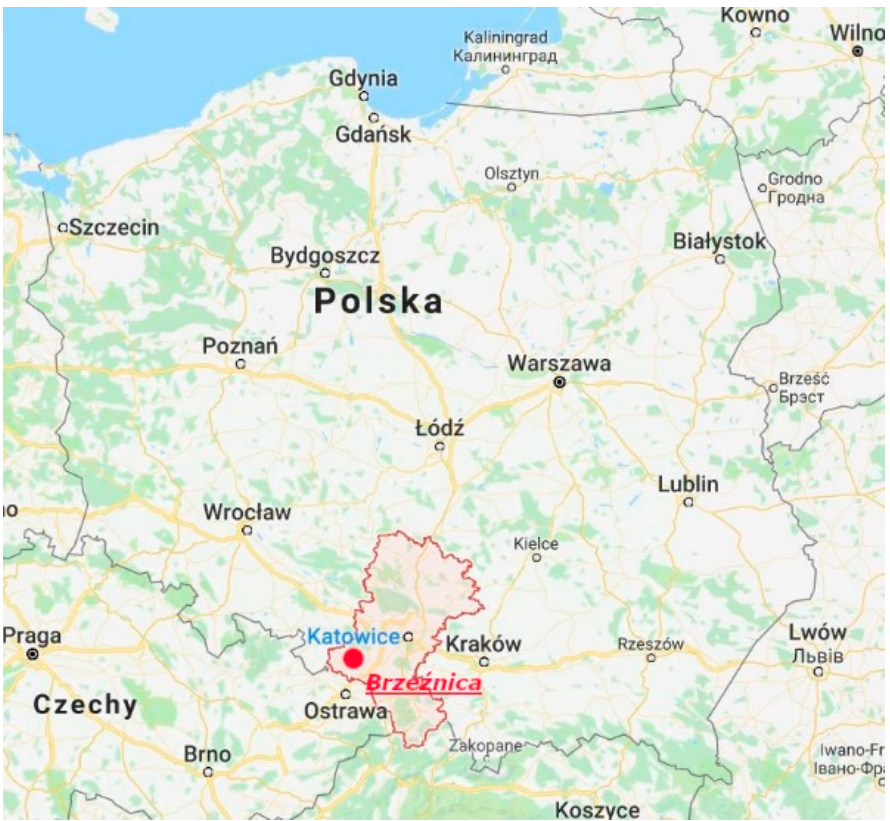
Figure 1. Location of the investigated site (source: www.google.pl/maps (accessed on 20 November 2022)).